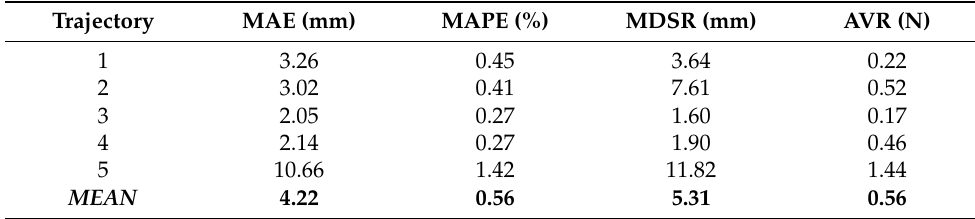
Table 5. Performance of the hybrid controller using SRM-V1 in the experimentation.